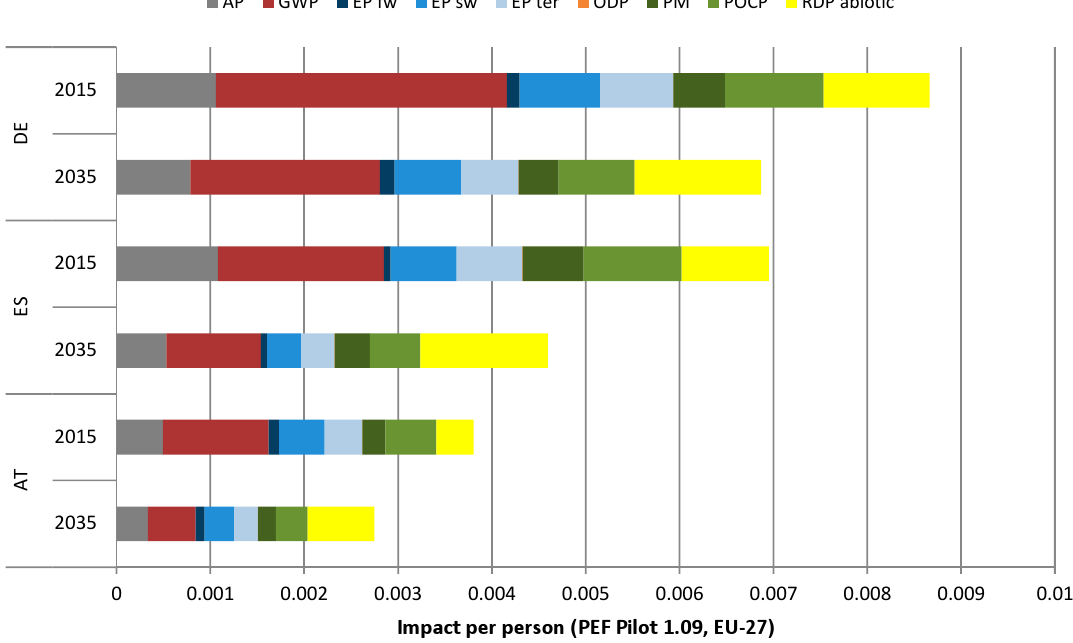
Figure 7. Comparison of normalized environmental impacts based on impacts per functional unit.